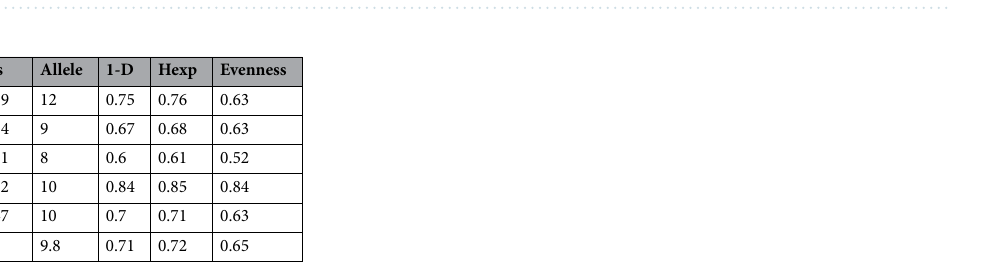
Figure 1. Process of amplicon sequence analysis.